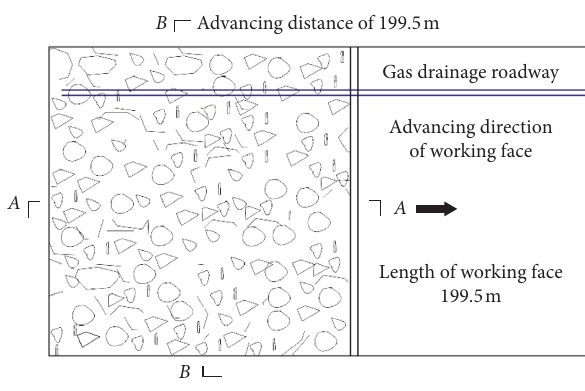
Figure 5: Distribution results of fracture zone. Figure